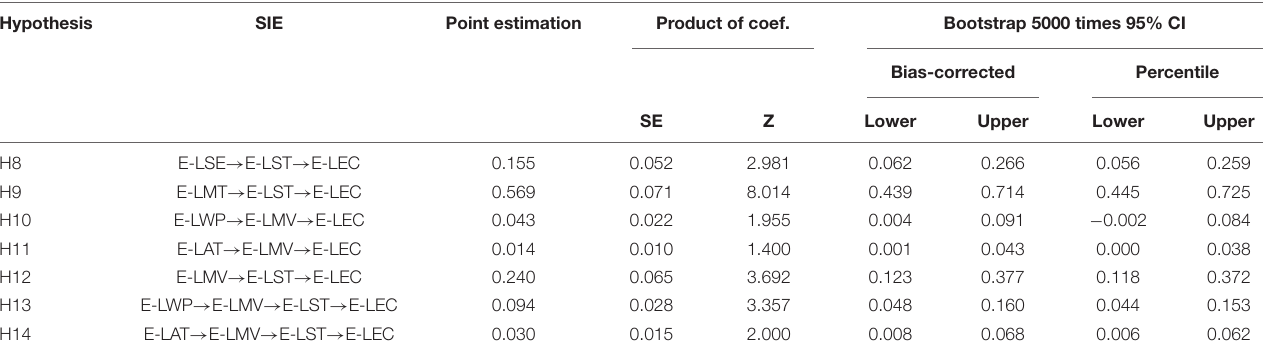
TABLE 5 | Standardized indirect, and total effects of the hypothesized model. Hypothesis